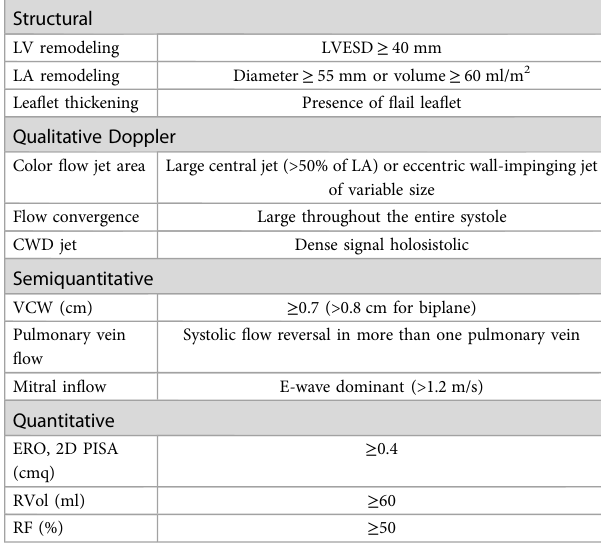
TABLE 1 Echocardiographic features encountered in MVP and indicators of severe chronic regurgitation.